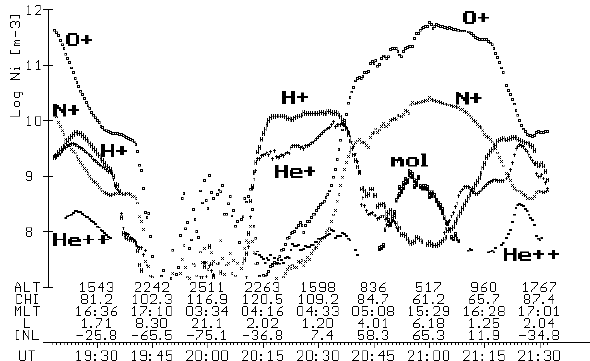
Fig. 1. Example of ion composition between 500 and 2500km as measured by the ion mass spectrometer on board the IK-24 satel- lite (ACTIVE mission) including minor ions. ALT-altitude, CHI- solar zenith angle, MLT-magnetic local time, L-McIlwain parame- ter, INL-invariant latitude, UT-Universal Time, mol-molecular ions (N 2 , NO + ), 15 April 1990.